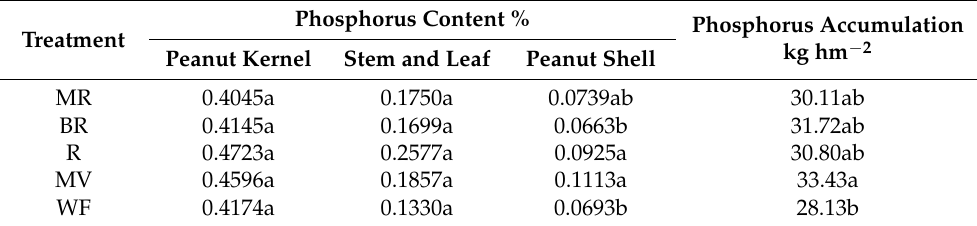
Table 5. Effects of green manure return on phosphorus uptake of